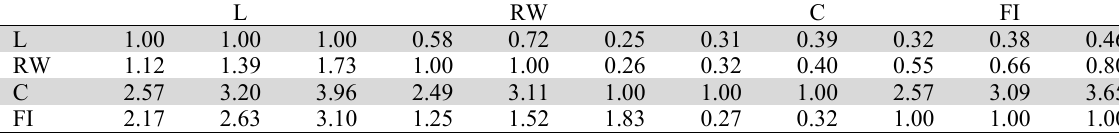
Aggregated fuzzy comparison matrix of criteria (Output)